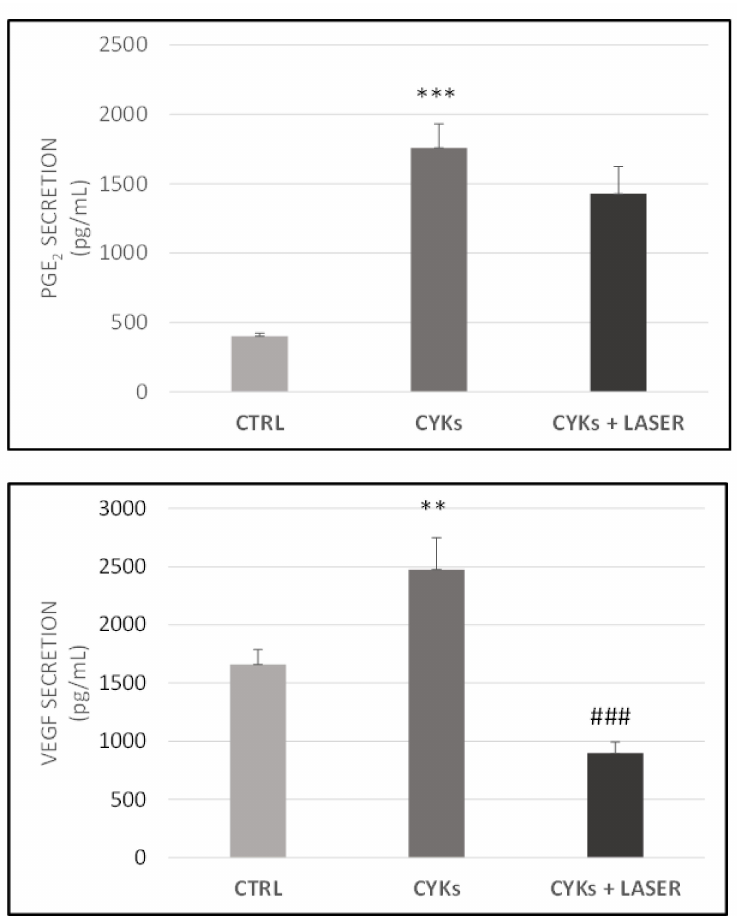
Figure 3. Modulation of PGE-2 and vascular endothelial growth factor (VEGF) release in NHDF cells exposed to pro-inflammatory cytokines and laser treatment. Fibroblasts were treated with IL-1 β and TNF- α , each at 10 ng/mL for 48 h, then the culture medium was replaced by fresh culture medium and samples divided into 3 groups: CYKs + Laser—samples stimulated with cytokine mix and then exposed to laser treatments (3 treatments, repeated once a day, for 3 consecutive days); CYKs—samples stimulated with cytokine mix and not exposed to laser treatment; CTRL—samples not stimulated and not exposed to laser treatment. Six hours after the third laser treatment, all samples were recovered, and PGE-2 (upper panel) and VEGF (lower panel) levels were evaluated in conditioned media using specific ELISA kits. Dosing of each condition was performed in double, and quantification is expressed as pg/mL. Data represent means +/ − SD ( n = 2) ** p < 0.01 and *** p < 0.001 CYKs group vs. CTRL group, ### p < 0.001 CYKs + Laser group vs. CYKs